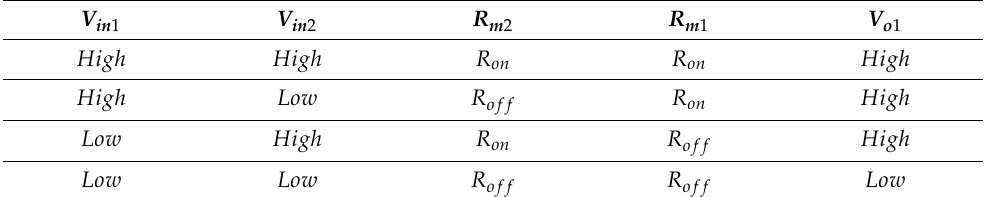
Table 3. The different states of each memristor for Figure